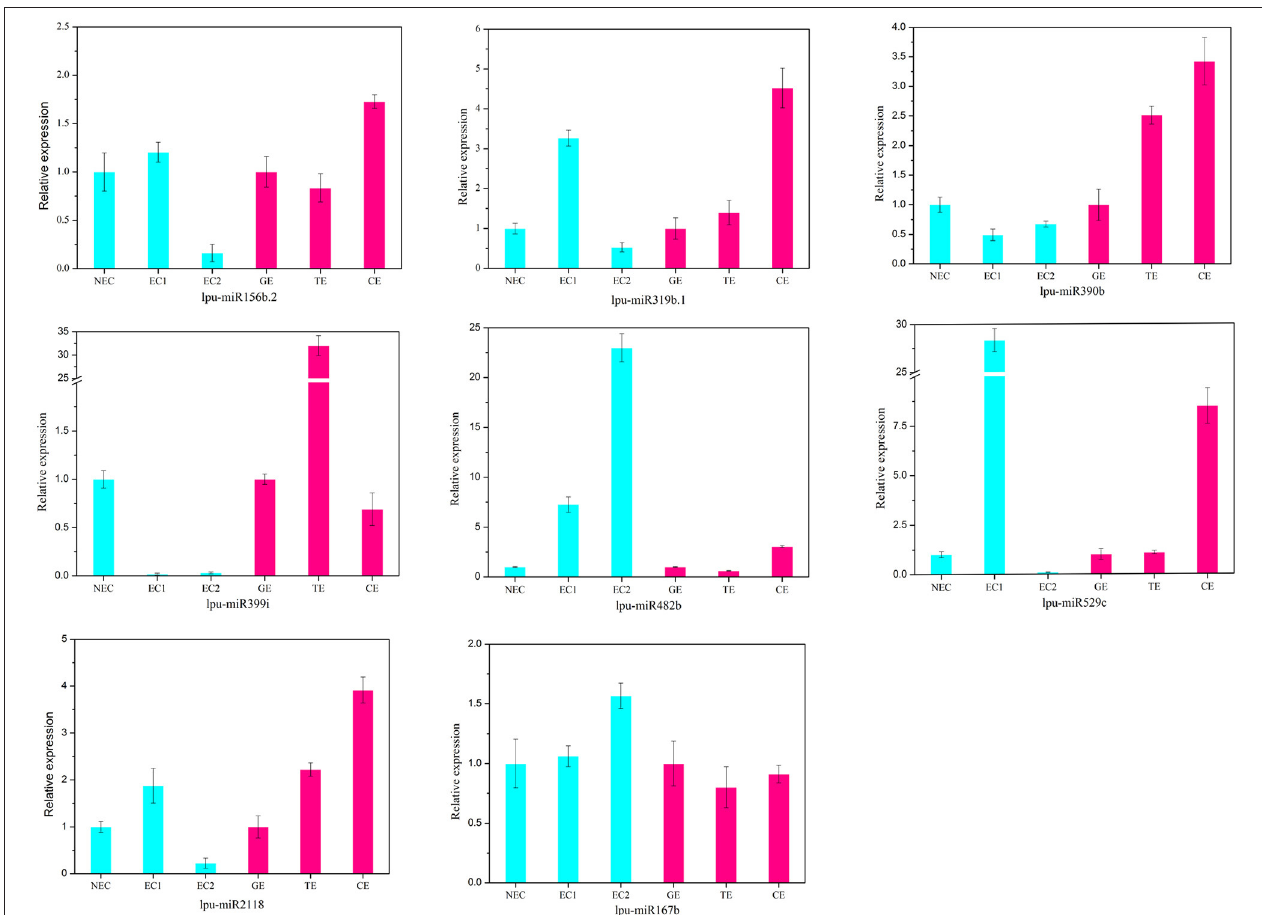
FIGURE 6 | Validation and comparison of miRNAs with different expression levels using qRT-PCR. NEC, non-embryogenic callus; EC1, embryogenic callus induced in 4 weeks; EC2, embryogenic callus induced in 6 weeks; GE, globular embryo; TE, torpedo embryo; CE, cotyledon embryo. The qRT-PCR values are the means ± SE of three